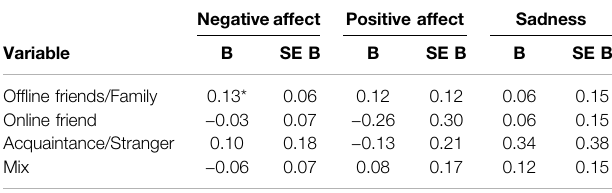
TABLE 2 | Generalized Estimating Equation (GEE) model predicting momentary affect by relationship type.